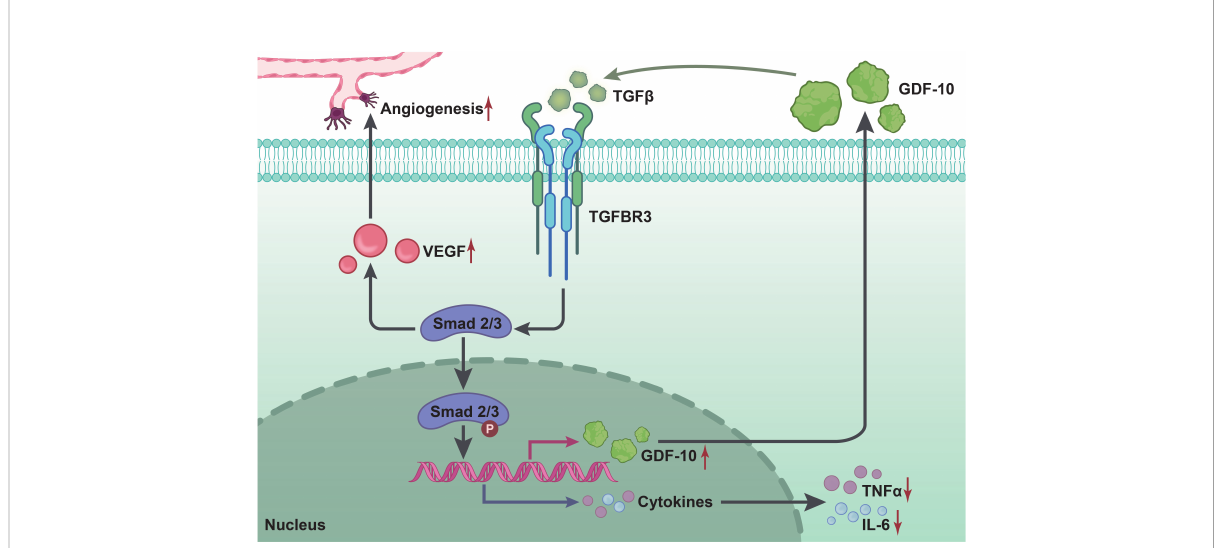
FIGURE 8 Molecular mechanism diagram of GDF10 regulating TGF- b 1/smad3 signaling pathway to affect wound healing in rats with DFU. GDF10 reduces STZ-induced blood glucose levels in rats, inhibits the expression of in fl ammatory factors (TNF-a, IL-1 b , IL-L 6) and promotes growth factors (VEGF, TGF- b 1), thus activating TGF- b 1/smad3 signaling to regulate the expression of Ang-1 and collagen I/collagen III to induce angiogenesis, which promotes wound healing in